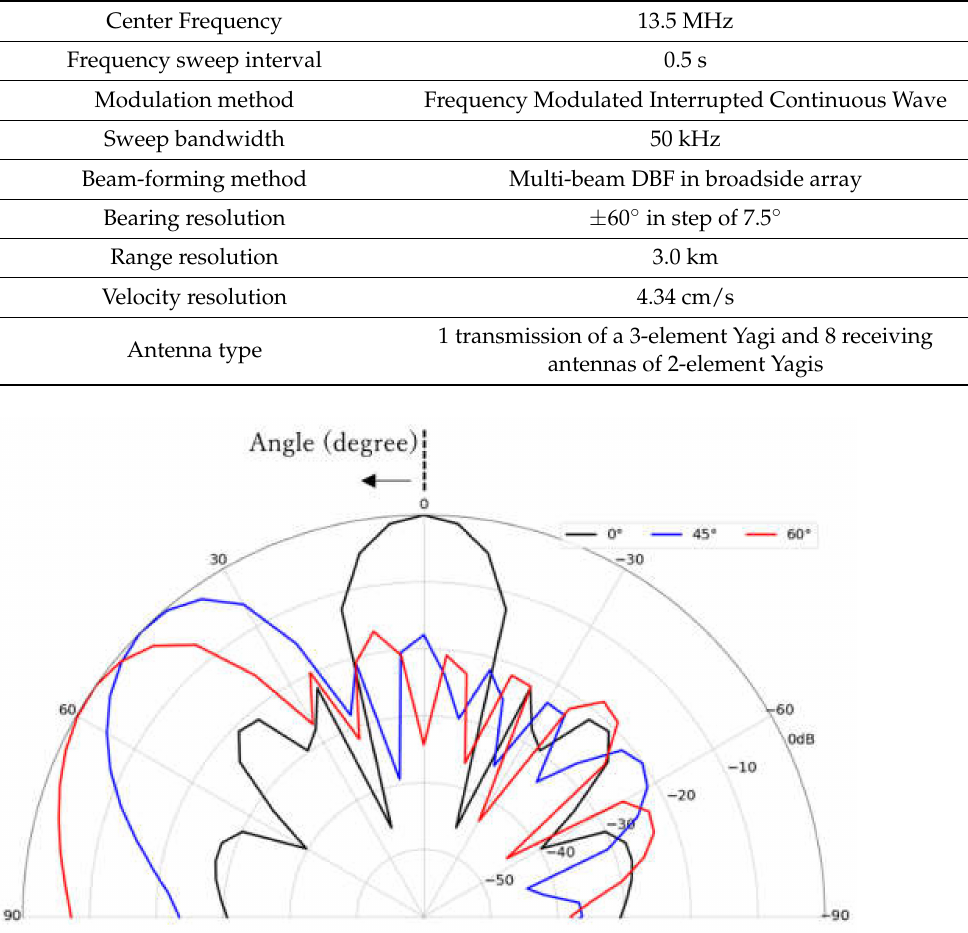
Figure 1. The receive array antenna beam pattern. This is the antenna pattern at each angle, with 0 degrees indicated by the black line, 45 degrees by the blue line, and 60 degrees by the red